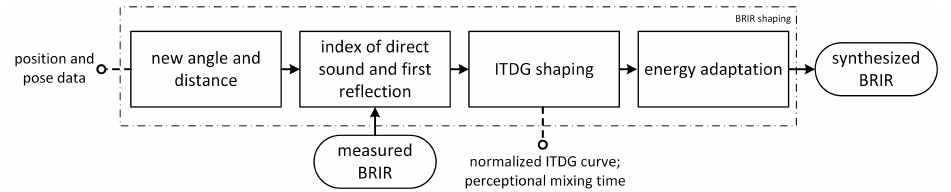
Figure 6. Block diagram of the synthesis approach adapting the initial time delay gap (ITDG) and using BRIRs of one measured position.